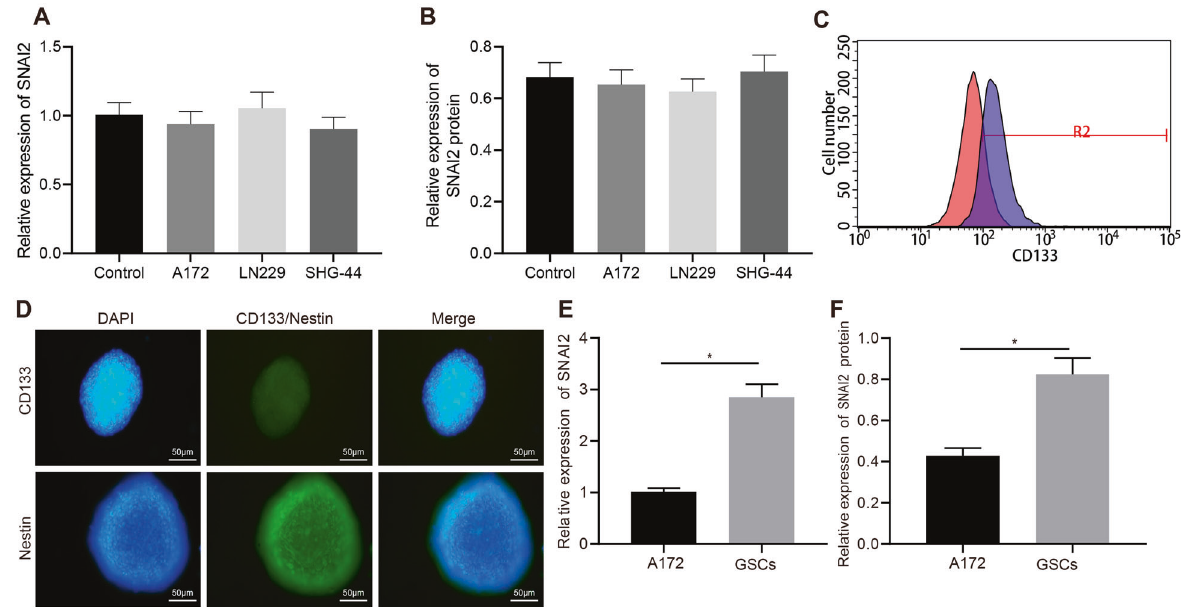
Fig. 2 SNAI2 expression is upregulated in GSCs. A SNAI2 mRNA expression in A172, LN229, and SHG-44 cells and human astrocytes as determined by RT-qPCR. B SNAI2 protein expression in A172, LN229, SHG-44 cells and human astrocytes as determined by Western blot assay. C CD133-positive cells as selected by fl ow cytometry. D The expression of CD133 (green) and Nestin (green) as measured by immuno fl uorescence. DAPI was stained in blue. E The mRNA expression of SNAI2 in GSCs and A172 cells as determined by RT-qPCR. F The protein expression of SNAI2 in GSCs and A172 cells as determined by Western blot assay. * p < 0.05 vs. A172 cells. Each cell experiment was repeated three times independently.